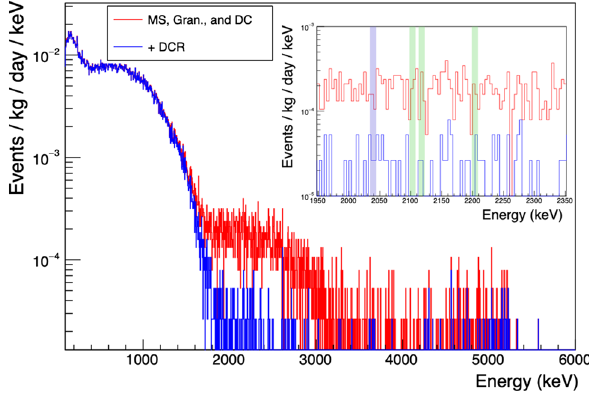
Fig. 14 Energy spectra from the Majorana Demonstrator ’s enriched detectors, including all data from Datasets 0 through 6 [7]. The red lines indicate the events kept by all other analyses (data clean- ing,environmental,muonveto,multiplicity,andAvs.Emulti-sitecuts). The blue line shows the events remaining after all cuts, including the DCR cut. The inset shows the effect of the DCR cut in the background estimation window. The regions excluded due to γ backgrounds are shaded in green and the 10keV window centered on Q ββ is shaded in